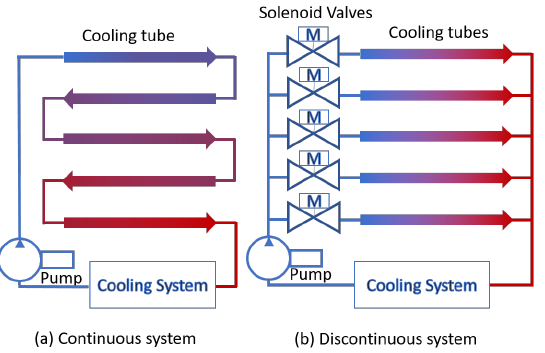
Figure 2. Models for traditional and proposed